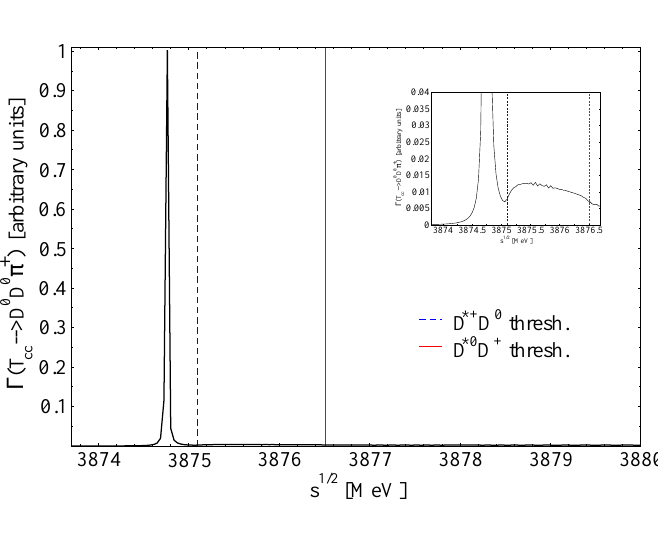
√ Figure 3. Γ ( s ) for the decay of the T cc into D 0 D 0 π + .The inset in the figure is a zoom to illustrate the mass distribution between D ∗ + D 0 and D ∗ 0 D +